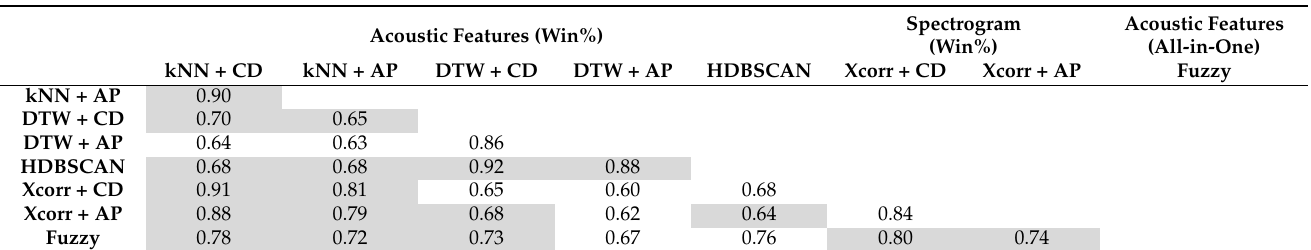
Table 4. Comparison of the determined harpy eagle vocalization labels using NMI. NMI values are shaded if NMI > 0.5 and ∆ Cluster ≤